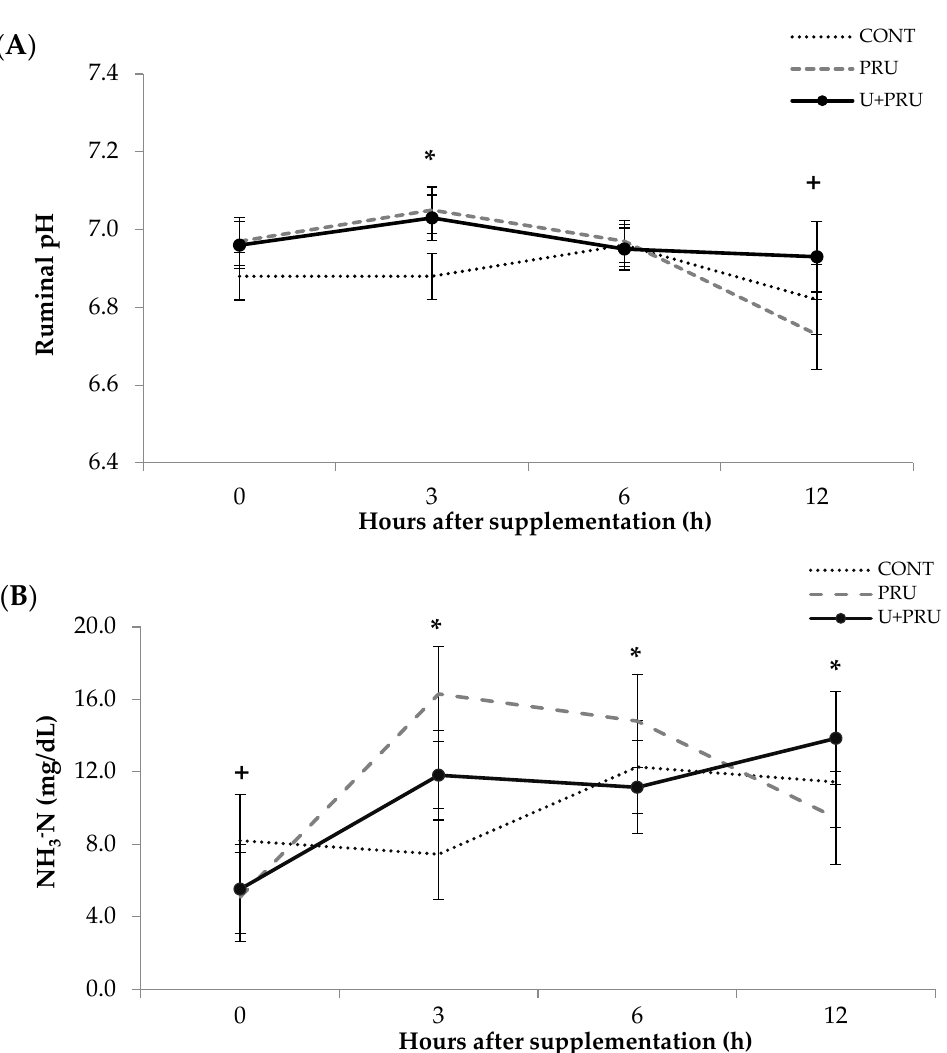
Figure 1. Mean and standard error means of ruminal pH ( A ) and ammonia nitrogen (NH 3 − N), ( B ) concentration recorded hours after supplementation, in Nellore steers supplemented with post- ruminal urea and conventional urea during the dry season. Effect of treatment and time interaction. * = significance ( p ≤ 0.05 ), and + = tendency ( p ≥ 0.05 and p ≤ 0.10). CONT: Conventional urea; PRU: Post-ruminal urea; U + PRU: Conventional urea + post-ruminal urea.